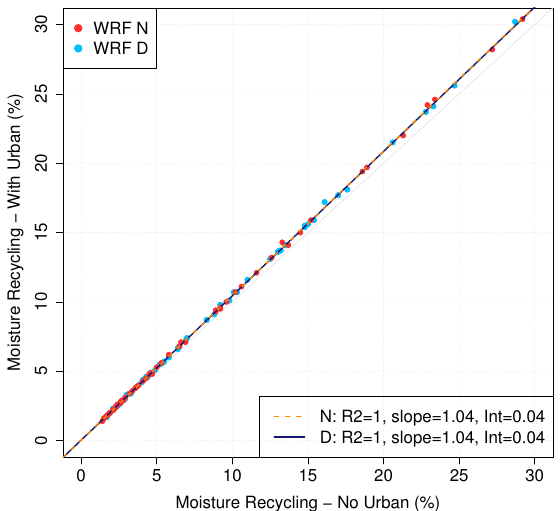
Figure 2. Scatterplot of the monthly moisture recycling values computed including the urban points and without them. Points in red are obtained for the WRF N experiment (no data assimilation), while the blue ones are for WRF D. The linear models of both experiments are plotted in orange and dark blue, and the details of the slope and the intercept of each of them are included in the right bottom corner of the